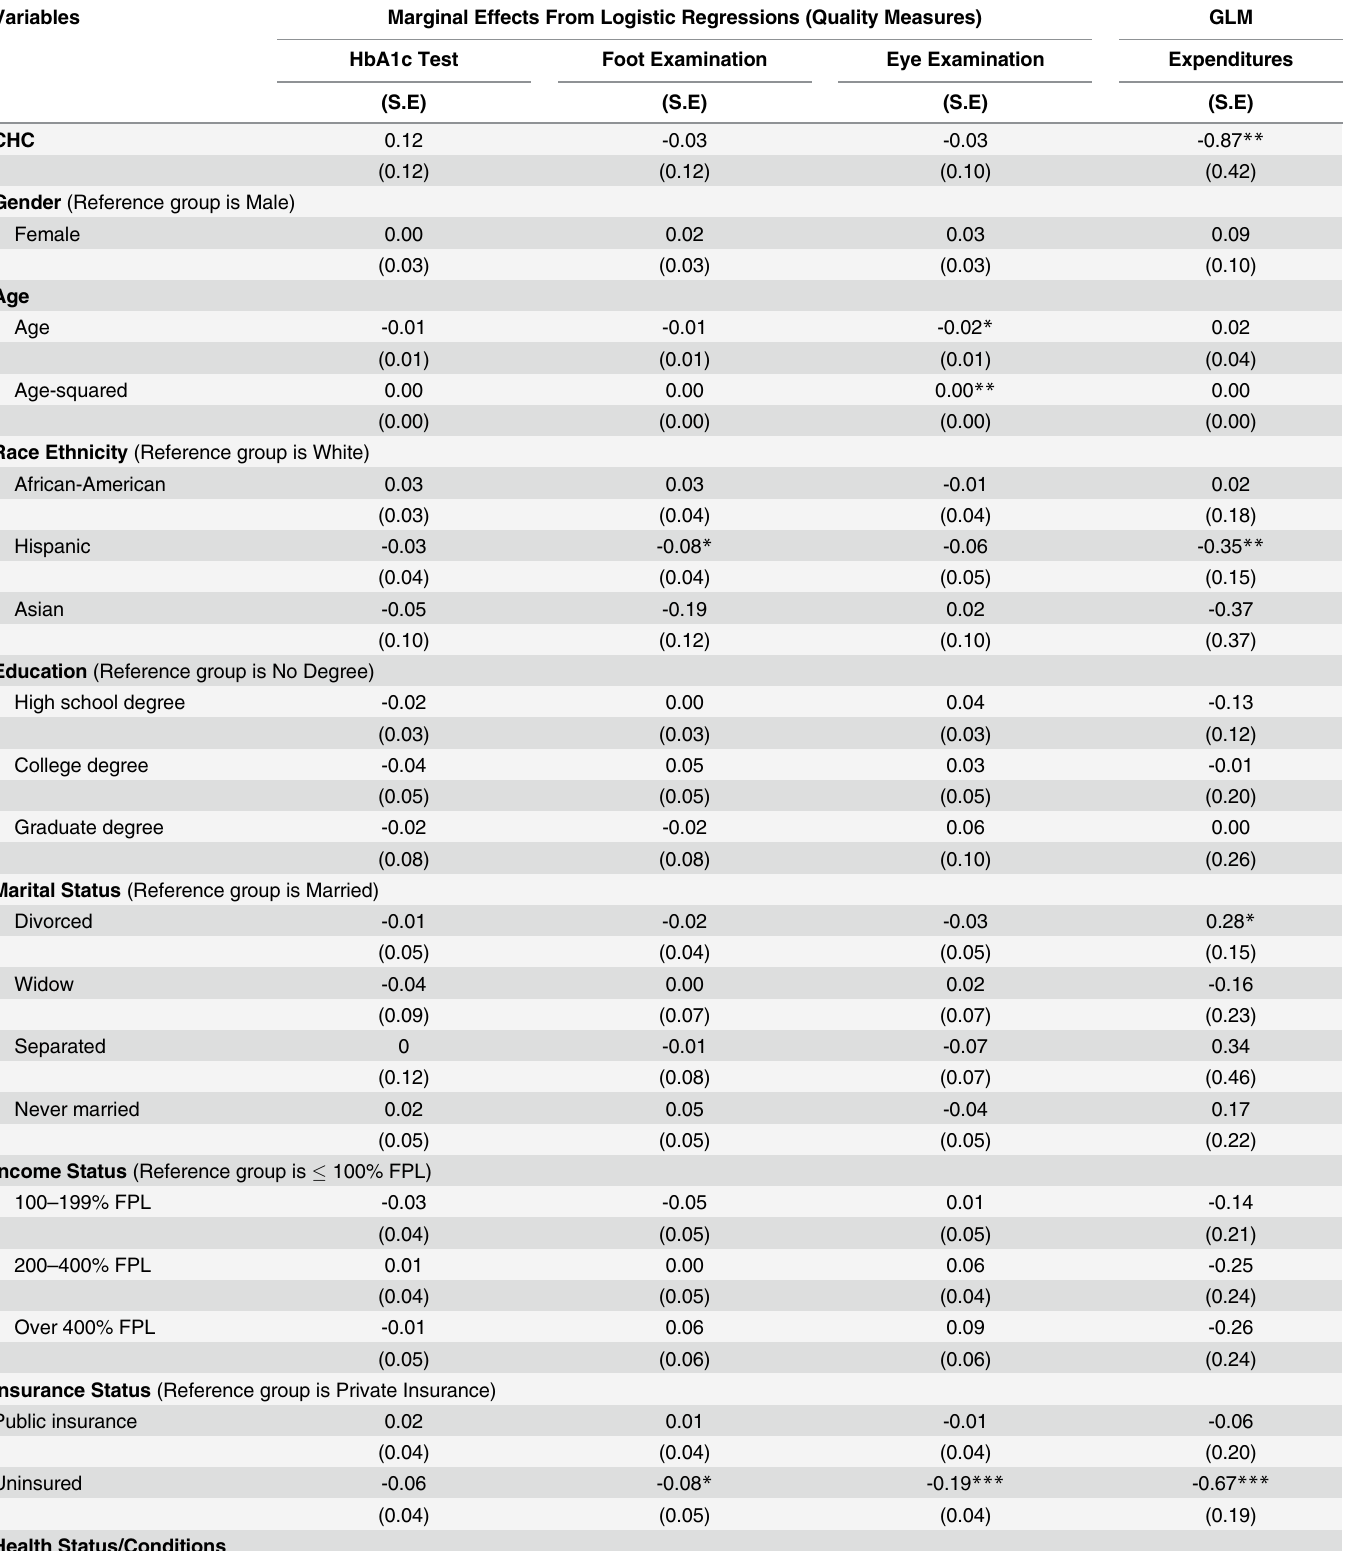
Table 2. Results from Multivariate Models of Quality of Care and Expenditures for Patients with Diabetes Mellitus, MEPS 2005 –